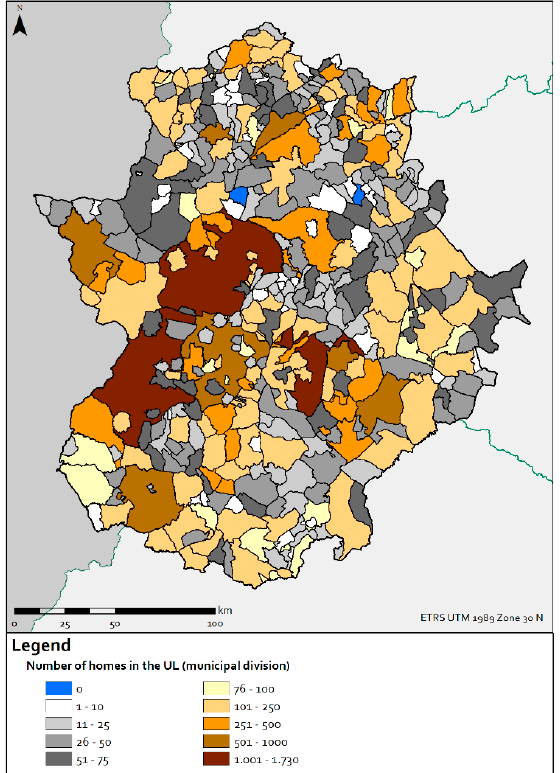
Figure 6. Number of homes on UL (municipal division).